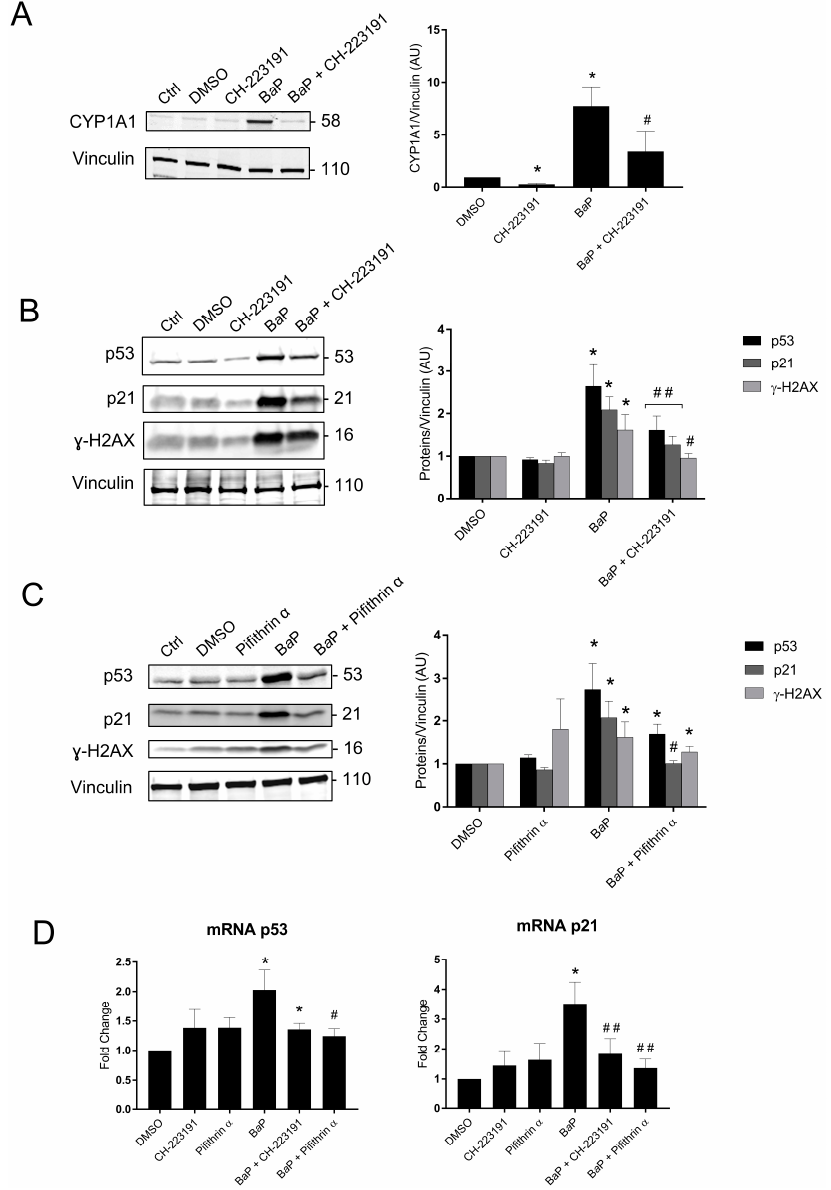
Figure 7. Protein expression and mRNA levels of p53 signaling and the AhR pathway after tro- phoblast exposure to benzo(a)pyrene. ( A – C ) VCT purified from term placentas were plated overnight and were untreated (control), incubated with DMSO or B a P (1 µ M), preincubated for 1 h with AhR antagonist (3 µ M), preincubated for 1 h with pifithrin- α (20 µ M), incubated with B a P (1 µ M) after preincubation for 1 h with AhR antagonist for 24 h, or incubated with B a P (1 µ M) after preincubation for 1 h with pifithrin- α for 24 h. Total protein extracts were subjected to SDS-PAGE under reducing conditions and membranes were immunoblotted with anti-CYP1A1, anti-p53, anti-p21, anti- γ H2AX, and anti-vinculin antibodies (loading control). Immunoblots were quantified with an Odyssey System Imager and the results represent the mean ± SEM after normalization to vinculin ( n = 6). * p < 0.05 vs. DMSO, # p < 0.05 vs. B a P, ## p < 0.01 vs. B a P. ( D ) VCT purified from term placentas were plated overnight and incubated with DMSO or B a P (1 µ M), preincubated for 1 h with AhR antagonist (3 µ M) or pifithrin- α (20 µ M), or incubated with B a P (1 µ M) after preincubation for 1 h with AhR antagonist or pifithrin- α for 24 h. Total mRNA was extracted from VCT, followed by reverse transcription. RT-qPCR was performed for the genes of interest, i.e., p53 and p21. The results, expressed as fold change, represent the mean ± SEM after normalization to the geometric mean of the reference genes HPRT, RPLO, and SDHA ( n = 5). * p < 0.05 vs. DMSO, # p < 0.05 vs. B a P, ## p < 0.01 vs. B a